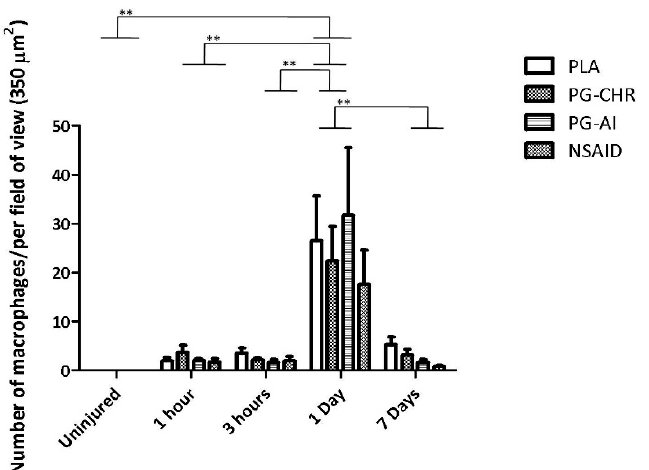
Figure 3. Macrophage infiltration into injured area after contusion injury with/without P. glandulosa treatment. The data are expressed as mean ± SEM. Analysis was done by two-way ANOVA. n = 5 per time-point/per group; Differences over time are indicated by solid lines; Significance: All groups: ** p < 0.001 uninjured vs. 1 day; 1 h vs. 1 day; 3 h vs. 1 day; 7 days vs. 1